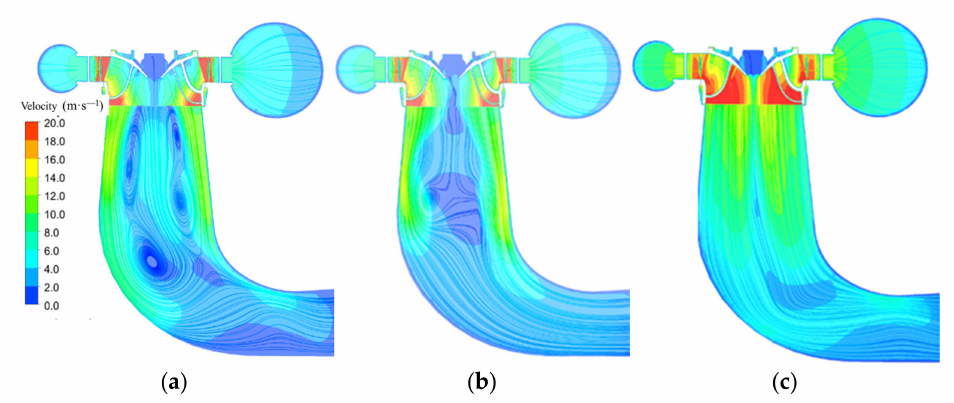
Figure 7. Overall flow pattern of internal section of hydraulic turbine with different opening. ( a ) 15 ◦ ( b ) 20 ◦ ( c ) 30 ◦ .